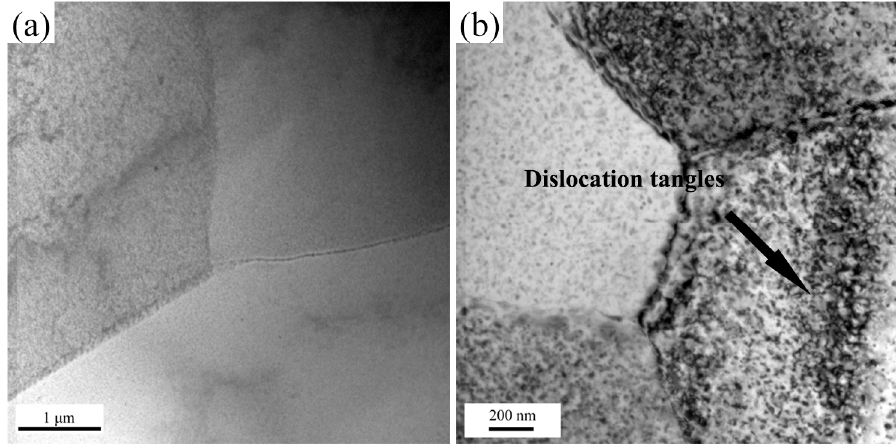
Figure 8. Transmission electron microscopy (TEM) microstructures of specimens deformed under different parameters. ( a ) 500 °C /0.01 s − 1 (ln Z = 20.9); ( b ) 450 °C /1 s − 1 (ln Z = 27.3).